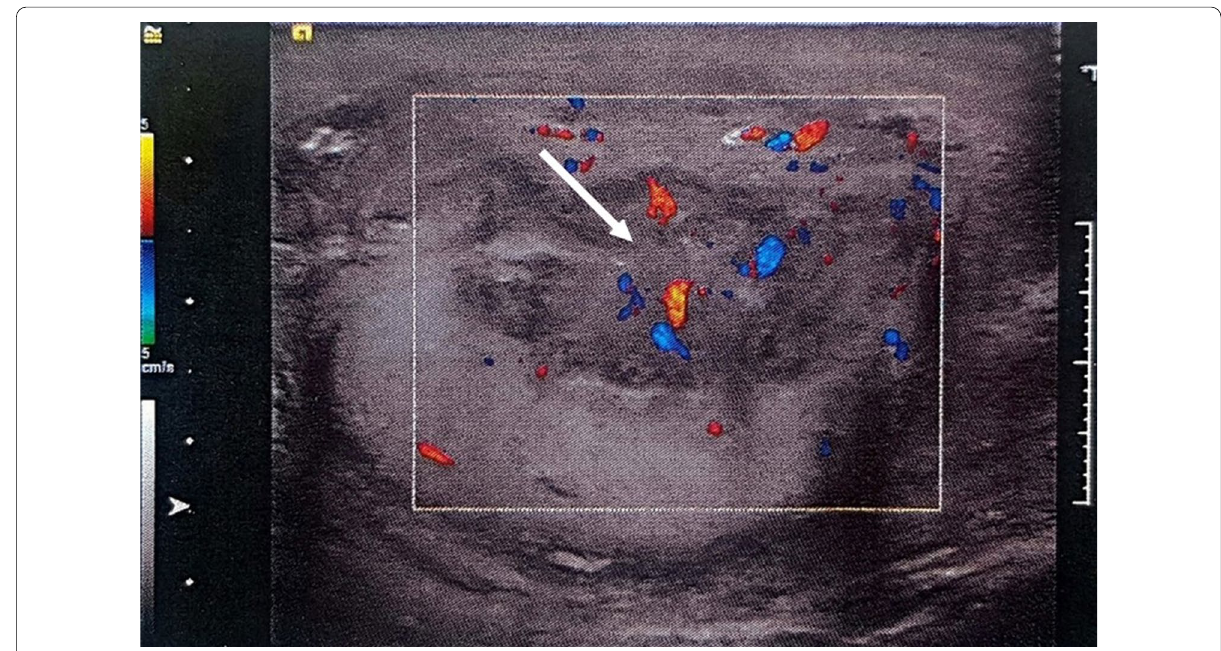
Fig. 2 Color Doppler image showing internal vascularity of the testicular mass